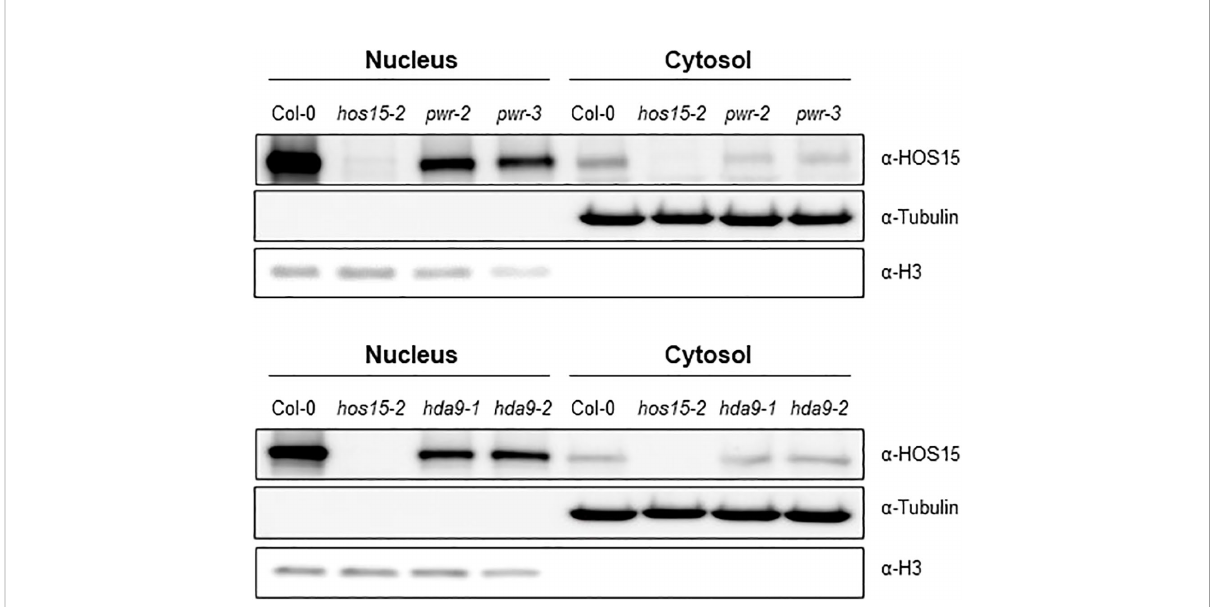
FIGURE 3 Decreased HOS15 nuclear accumulation in pwr and hda9 mutants. Immunoblotting of HOS15 protein in two-week-old plants of Col-0, hos15- 2 , hda9 and pwr mutants. Total protein was extracted and separated into cytoplasmic (cytosol) and nuclear (nucleus) fractions and immunoblotted with an anti-HOS15 antibody. a -Tubulin and histone H3 served as loading controls for the cytosol and nucleus,